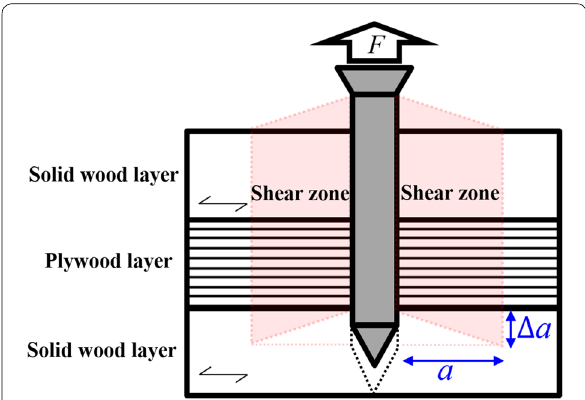
Fig. 1 Shear mechanism of screw in a panel composed of solid wood and